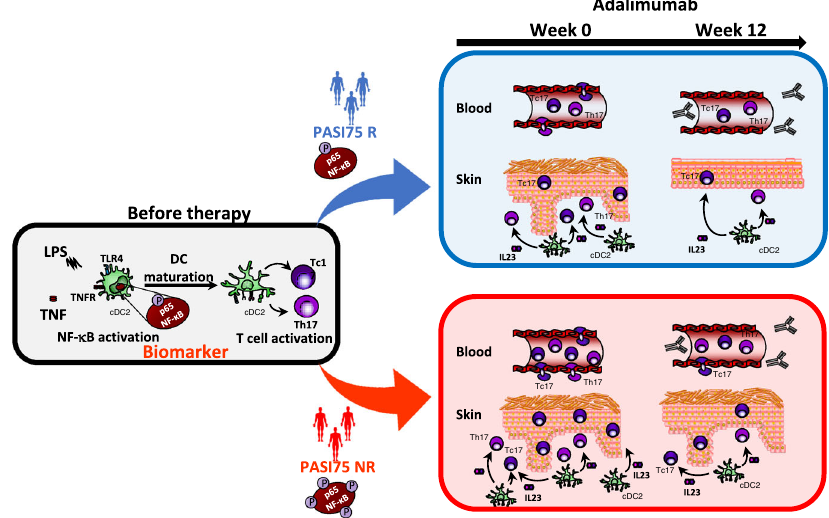
Fig. 7 Mechanistic biomarker of response to adalimumab. Phosphorylation of p65NF- κ B in conventional Type 2 dendritic cells (cDC2) before therapy is an early predictive biomarker of response to adalimumab at week 12. NF-kB activation by TNF or TLR ligands, e.g., LPS, induces DC maturation which in turn leads to the activation of IL-17A producing T helper (Th)17 and CD8 + T cytotoxic (Tc)17 cells. This is enhanced in PASI 75 non responder patients (PASI75 NR), as shown in the cartoon by the increased number of phosphorylation sites on NF-kB underneath the patient silhouettes, and results in increased number of activated DC producing IL-23 in the skin and of Th17 and Tc17 in blood and skin before therapy, as compared to PASI75 responders (PASI75 R). TNF-blockade by adalimumab reduces DC and T cell responses but they remain elevated in the blood and skin of PASI75 non-responders underpinning the lack of clinical